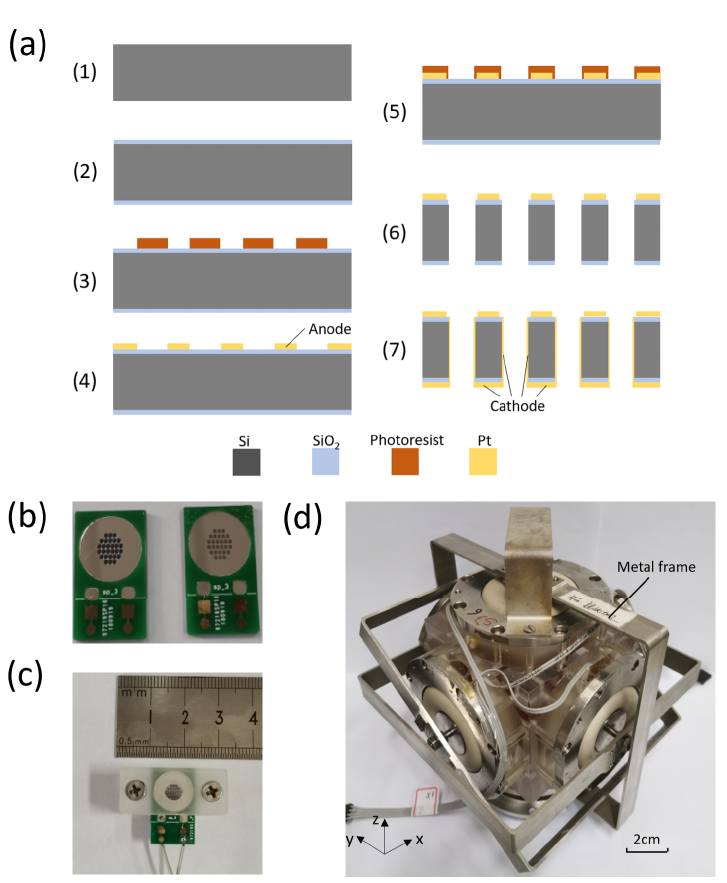
Figure 4. Manufacturing process of sensitive electrode ( a ) and fabrication process of the integrated MEMS based triaxial electrochemical seismometer ( b – d ) with a prototype device shown in ( d ).